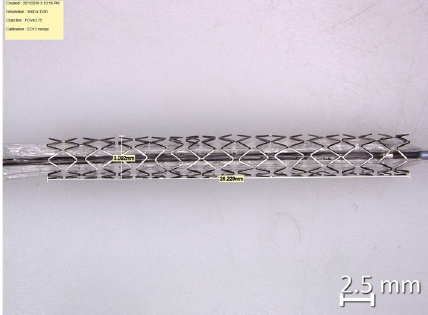
Figure 10: Strut of Envision 3 : 5 × 28 after expansion.